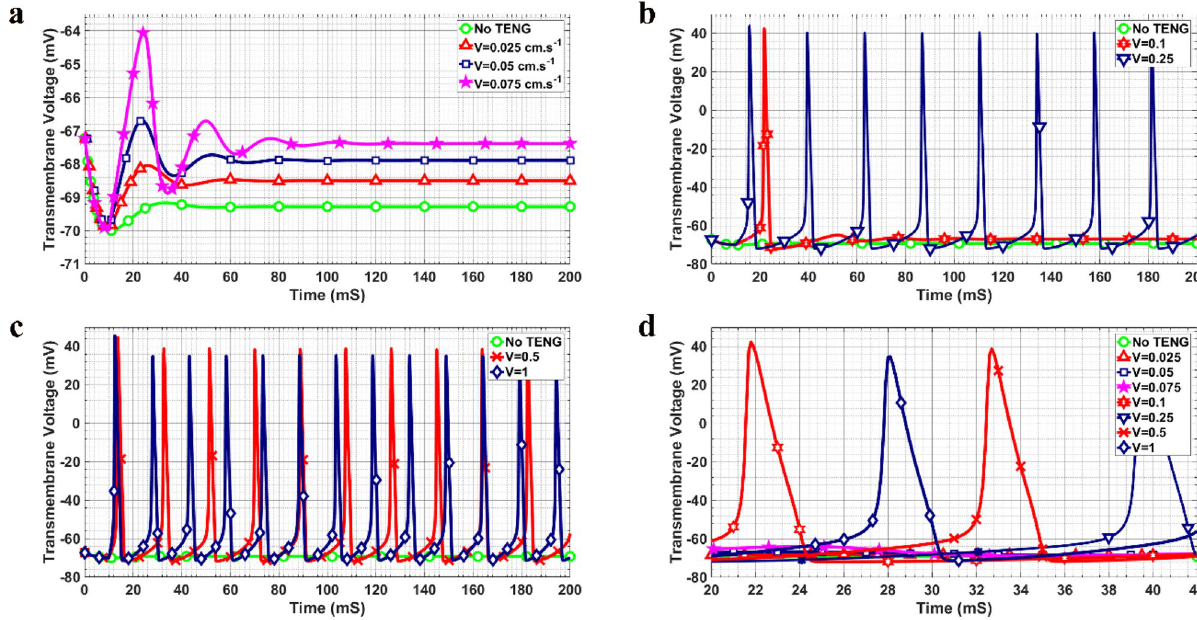
Figure 4. Transmembrane voltage of the resting neuron for different contact-release speeds of ( a ) 0.025– 0.075 cm.s −1 and without the TENG, ( b ) 0.1–0.25 cm.s −1 , ( c ) 0.5–1 cm.s −1 , ( d ) results for the time duration between 20 and 42 ms.